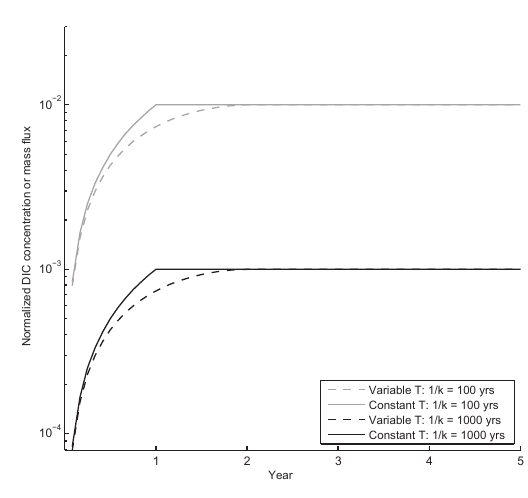
Fig. 5. DIC transport dynamics. Results are shown on log scale for single travel time ( τ = 1yr; solid curves) and variable, uniformly distributed τ (with average value of 1yr; dashed curves) for differ- ent values of release rate k (or characteristic release time 1 /k